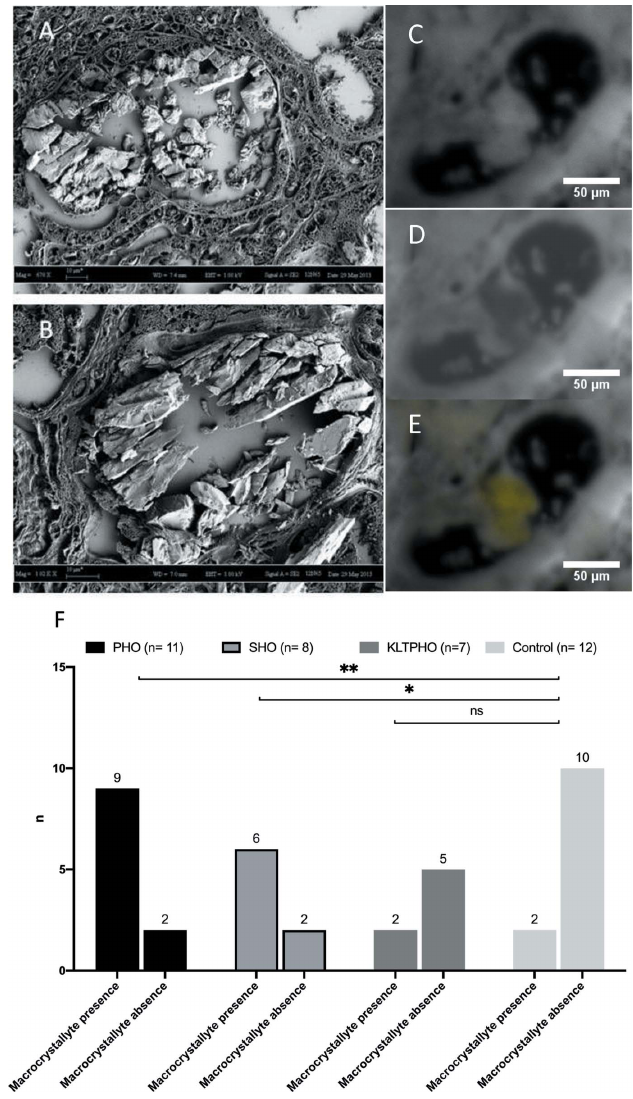
Figure 3 Synchrotron WFUVallows detection of CaOx macrocrystallites in kidney biopsies. (A, B) Scanning electron microscope observations of typical CaOx macrocrystallites in the tubule lumens. Fluorescence is bright in the 412–438 nm channel (C) and shallow in the 327–353 nm channel (D) which results in a yellow subtract signal (E) evocative of CaOx composition. (F) Macrocrystal presence is significantly more frequent in PHO and SHO patients than in control biopsies, while it is not frequent in KLTPHO patients. ** p < 0.01; * p < 0.05; ns: not